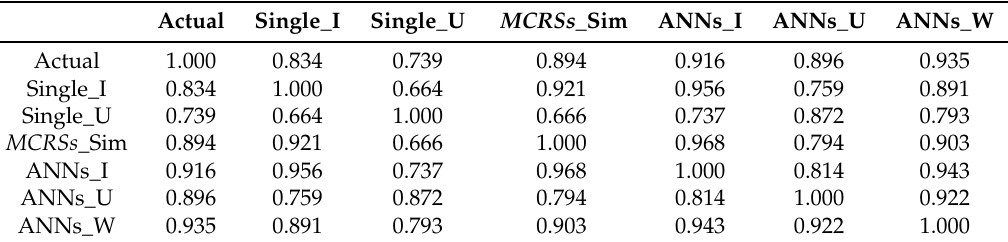
Table 5. Correlation matrix between the actual rating and the predicted